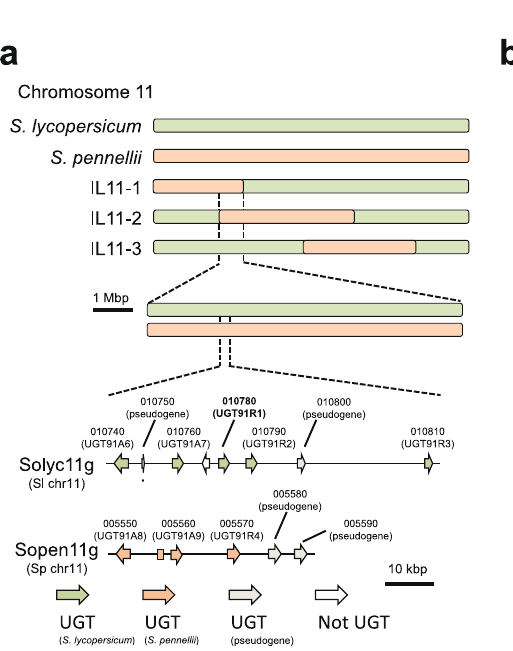
Fig. 2 | Genetic and phylogenetic tree analyses of glycosyltransferases located in overlapregion of S. pennellii chromosome segment betweenIL11-1 and IL11- 2. a Schematic diagram of tomato chromosome 11 around the locus of gene involved in HexVic biosynthesis. Green and orange bars represent chromosome segments derived from S. lycopersicum and S. pennellii , respectively. Introgression line(IL)11-1,IL11-2,andIL11-3harbordifferentsegmentsof S.pennellii chromosome. Overlap region of S. pennellii chromosome segment between IL11-1 and IL11-2 contains a gene cluster encoding putative glycosyltransferases in both S. lyco- persicum and S. pennellii . Orientation of arrowhead indicates the orientation of